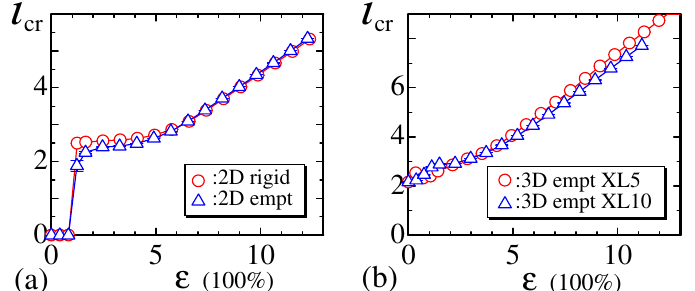
Figure 13. The mean length (cid:96) cr of crystalline bonds corresponding to ( a ) 2D rigid and empty models and ( b ) the 3D empty model for the experimental data XL5 and